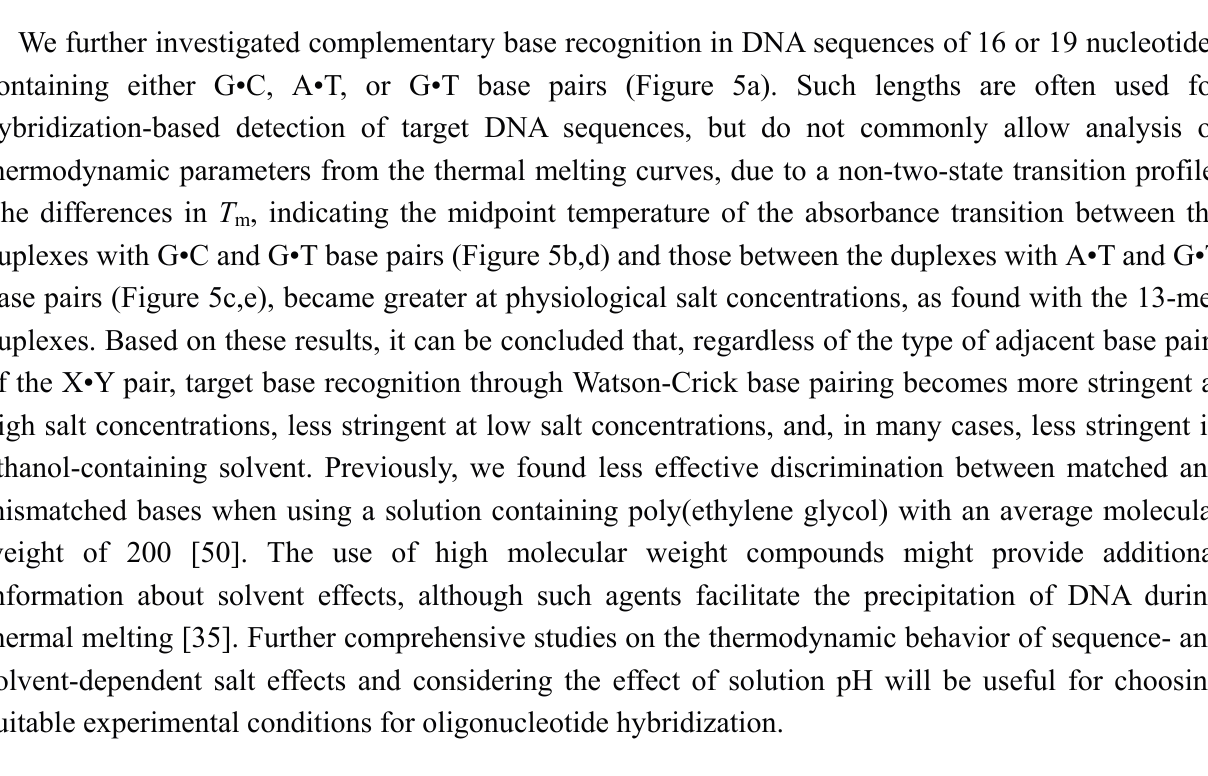
Figure 5. ( a ) DNA sequences of the 16-mer and 19-mer duplexes (X•Y = G•C, A•T or G•T); ( b – e ) Differences in the T values of 16-mer duplexes ( b , c ) and 19-mer duplexes ( d , e ) at m strand concentrations of 2 µM, at different concentrations of Na + (black), Na + with 3 M ethanol (red), or Mg 2+